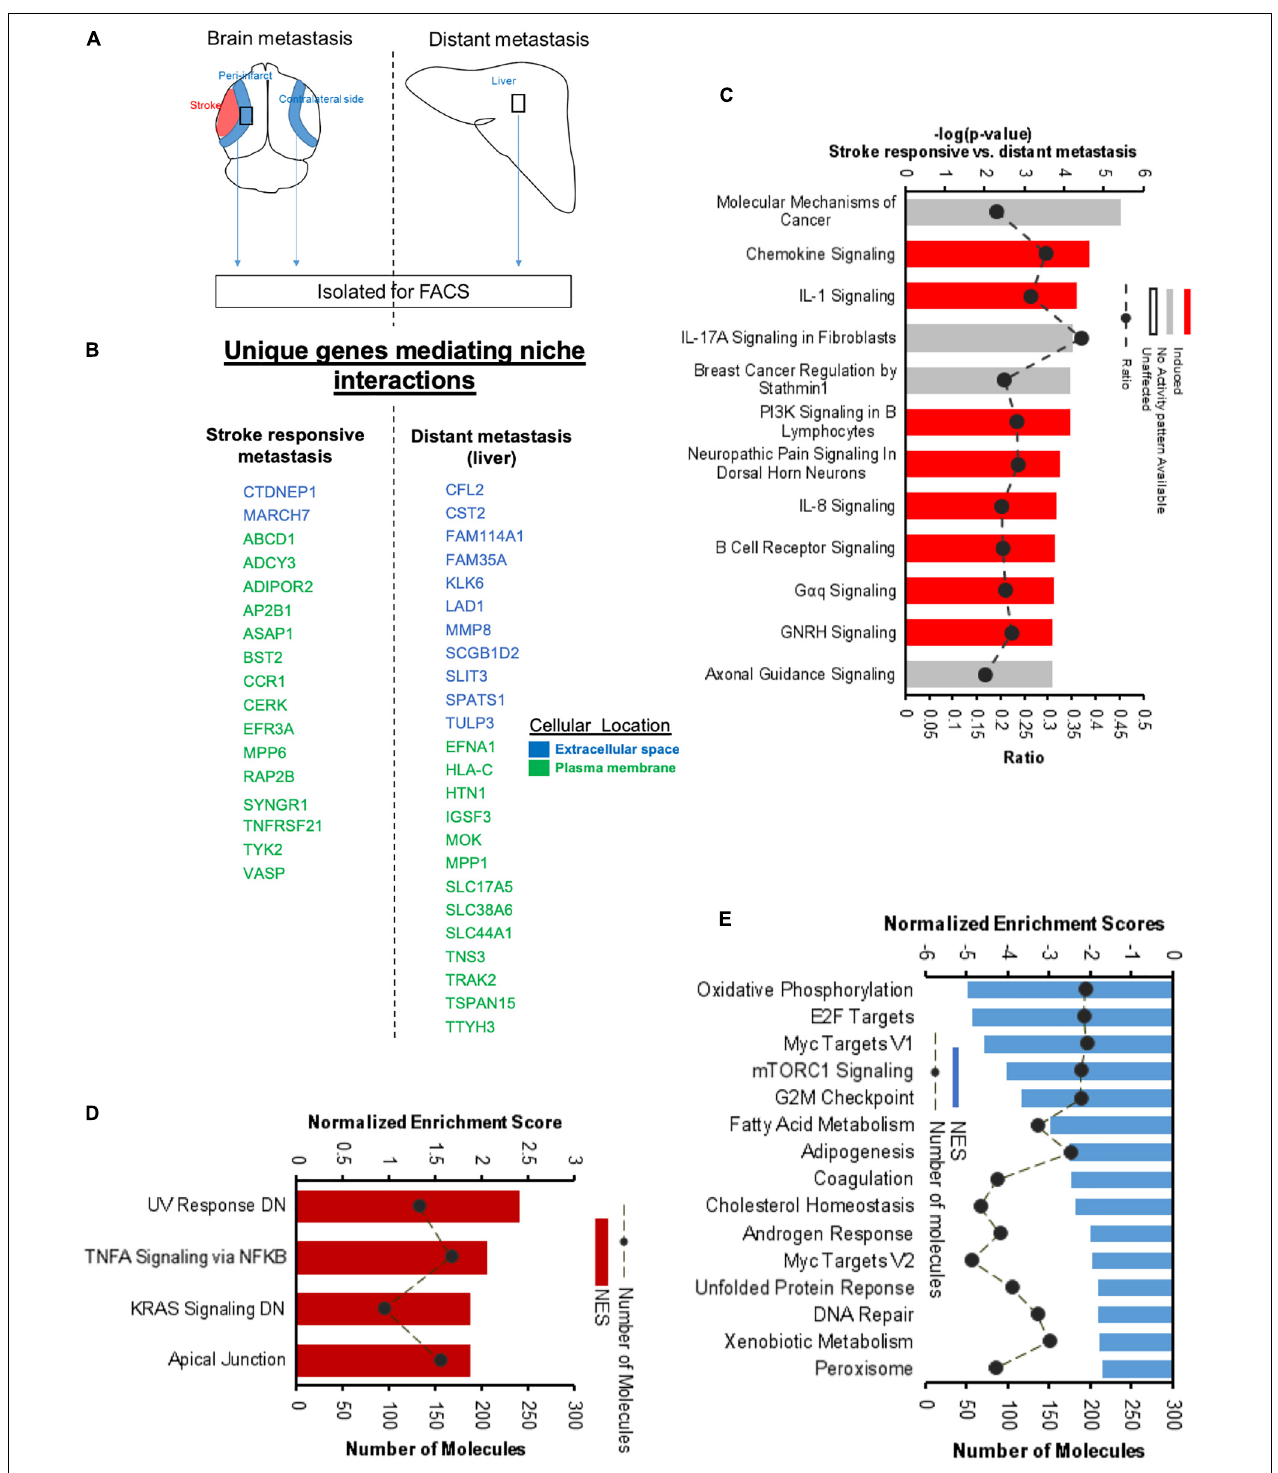
FIGURE 13 | Unique molecular signaling systems in brain metastasis. (A) Schematic representation of brain and distant sites of metastasis compared. The significant and differentially expressed genes between Brain metastasis (stroke responsive metastatic cells) and distant metastasis (liver metastasis) were compared. (B) Unique extracellular and plasma membrane genes that interact with the surrounding niche in each of these two transcriptomes were identified at FPKM values > 4. (C) Top canonical pathways differentially regulated in brain metastatic melanoma over a distant metastatic site (liver) with the largest negative logP values are shown. The dashed line represents the ratio of the number of molecules in the dataset over the number of molecules in the pathway. (D,E) GSEA of hallmark genes up and downregulated in the differentially expressed genes of brain metastatic vs. liver metastasis.